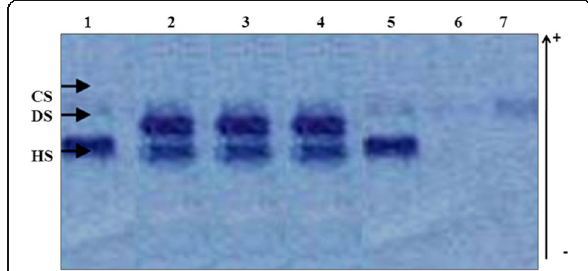
Fig. 1 MPS I electrophoresis profile on a cellulose acetate plate of the urinary GAGs. 1 and 5: MPS III controls; 2, 3 and 4: MPS I or MPS II patients; 6 and 7: Normal controls. CS: chondroitin sulphate; DS: dermatan sulphate; HS: heparan sulphate